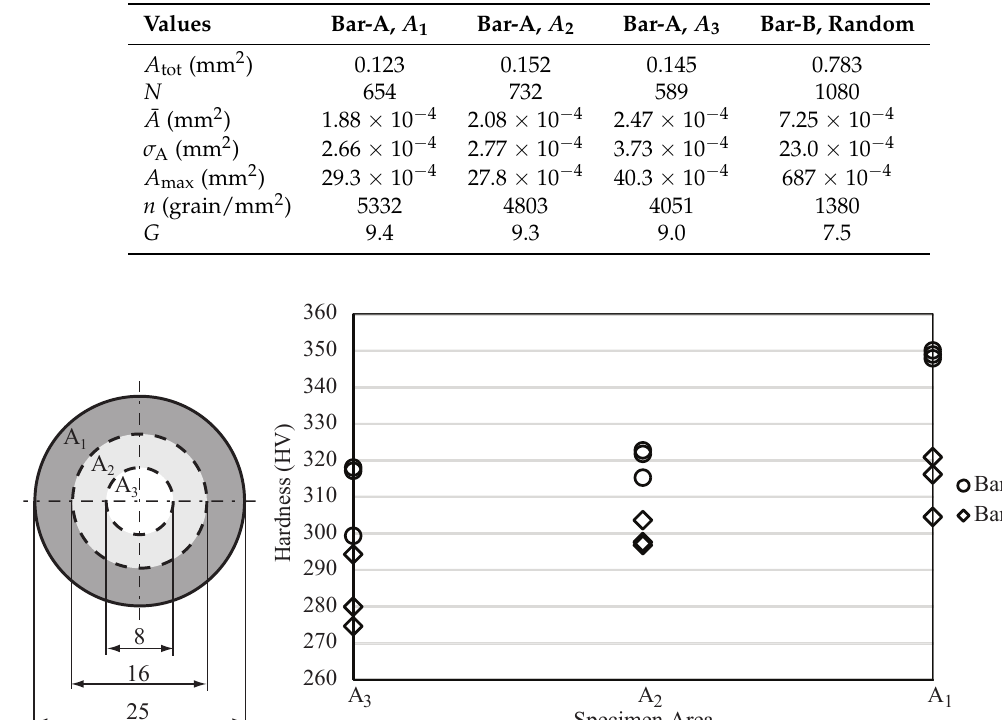
Table 4. Grain area analysis.